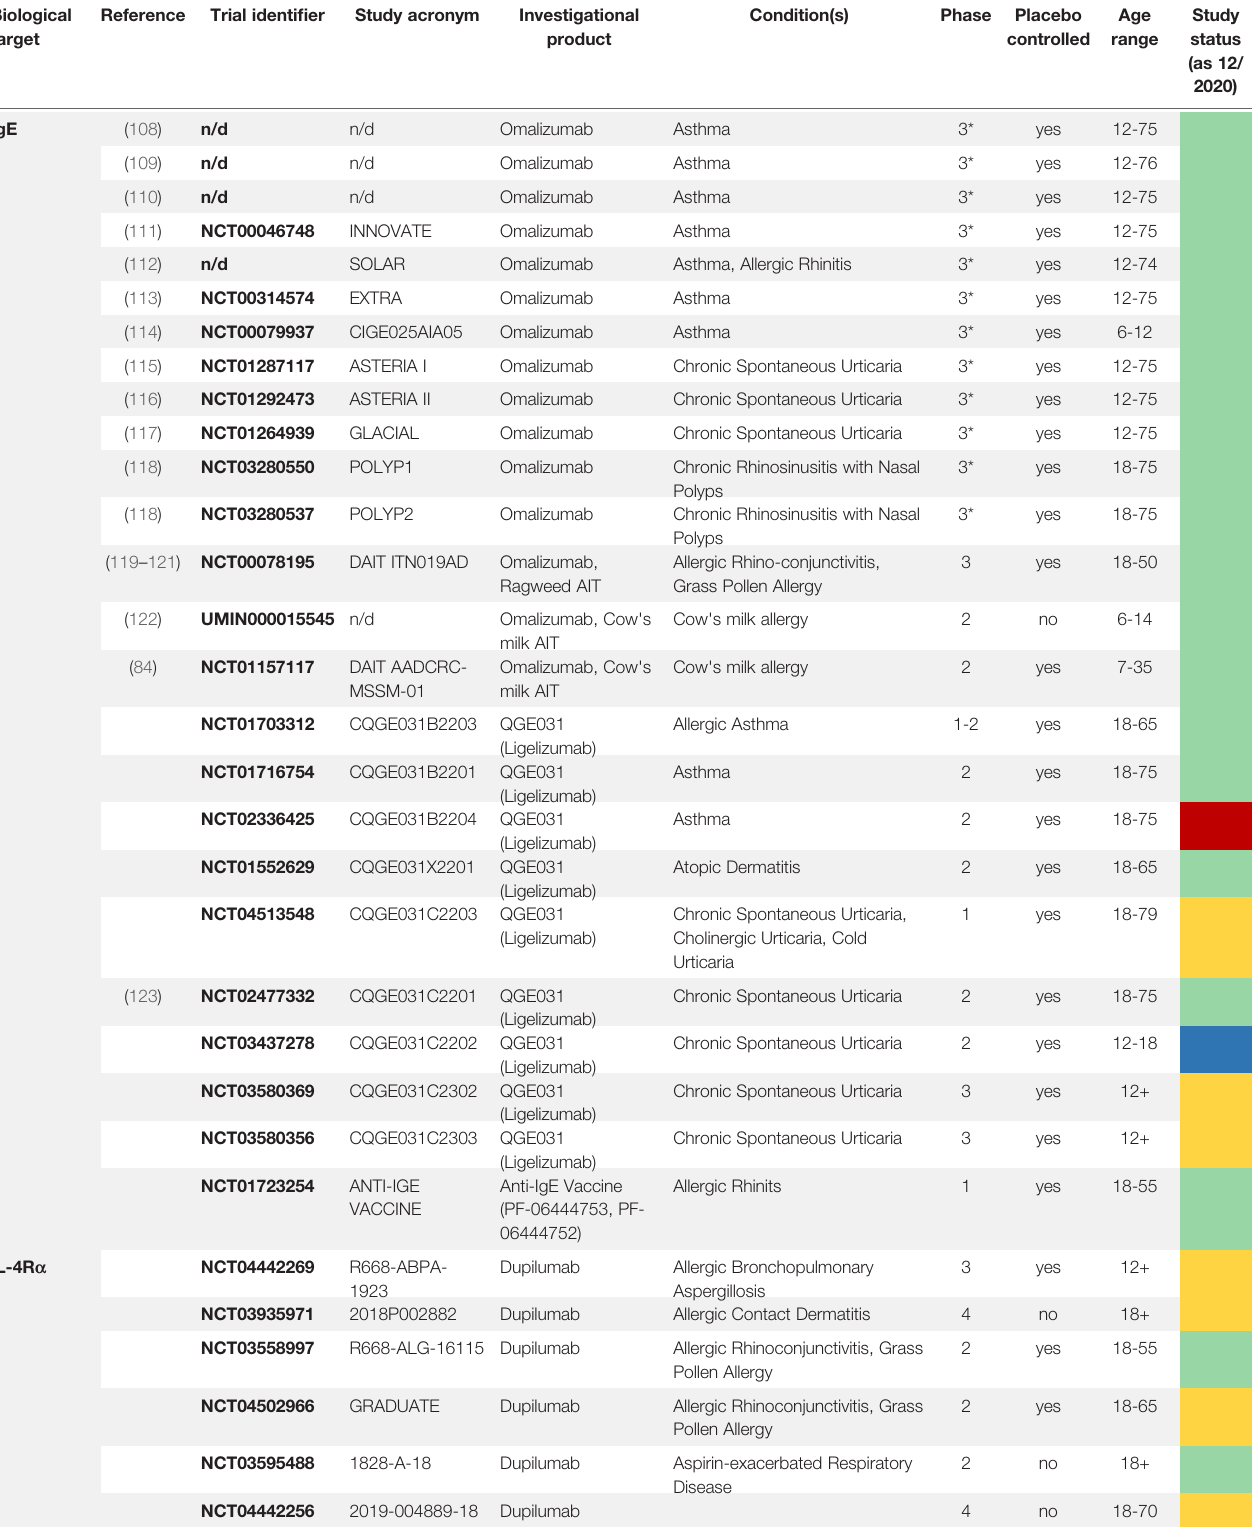
TABLE 2 | List of clinical trials on biologics targeting key mechanisms of MC activation for conditions other than peanut